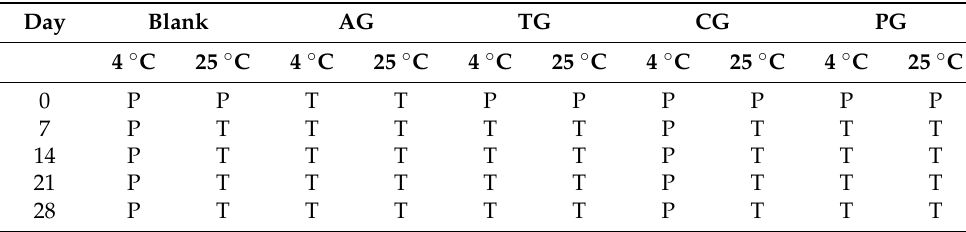
Table 4. Rheological behavior of the curves τ vs. D and η vs. D.